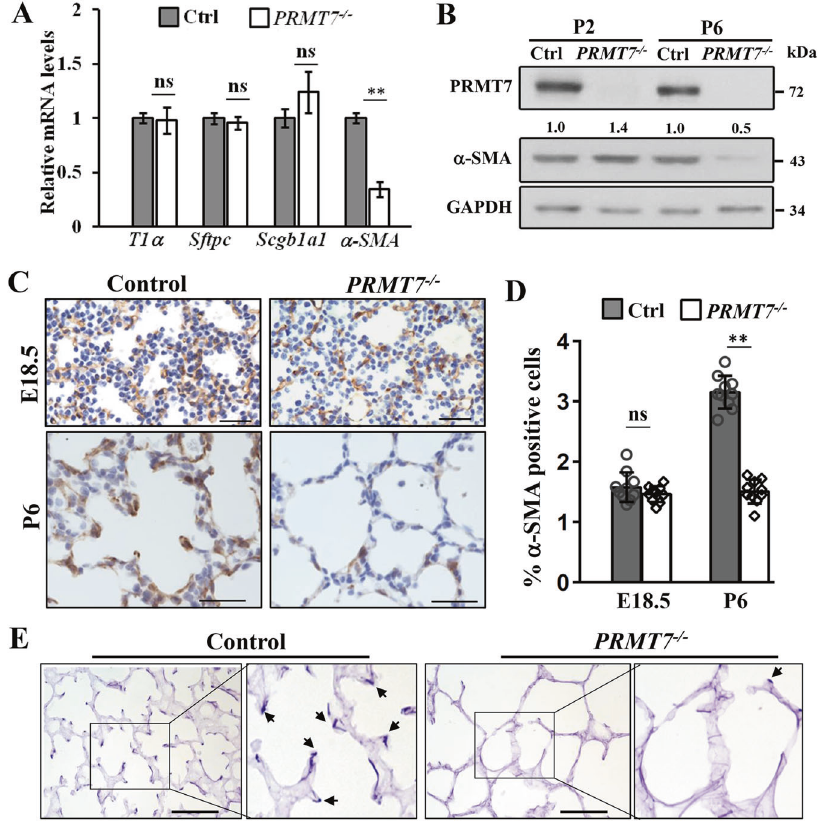
Fig. 2 Impaired α -SMA expression and reduced elastin deposition in PRMT7 − / − lungs. A qRT-PCR validation of expression of indicated genes in control and PRMT7 − / − lungs at P6. Data were normalized to β -actin and then to the control expression level. n = 6 biological replicates. Data were presented as mean ± SD. ns not signi fi cant, ** P < 0.01 (Student ’ s t -test). B PRMT7 and α -SMA protein expression were detected by western blotting in the lung tissues of PRMT7 − / − and control mice at P2 and P6. The relative level of α -SMA are listed above. C Representative α -SMA immunostaining images of PRMT7 − / − and control lungs at E18.5 and P6. Scale bars: 100 μ m. D Quantitative analysis of α -SMA positive cells in the alveolar region. Fifteen fi elds from at least three mice were calculated for each condition. ns not signi fi cant, ** P < 0.01 (Student ’ s t -test). E Gomori ’ s aldehyde fuchsin staining of elastin from control and PRMT7 − / − lungs at P6. Magni fi ed pictures from the boxed area were shown on the right panel. Arrows point to positive elastin staining signals. Scale bars: 100 μ